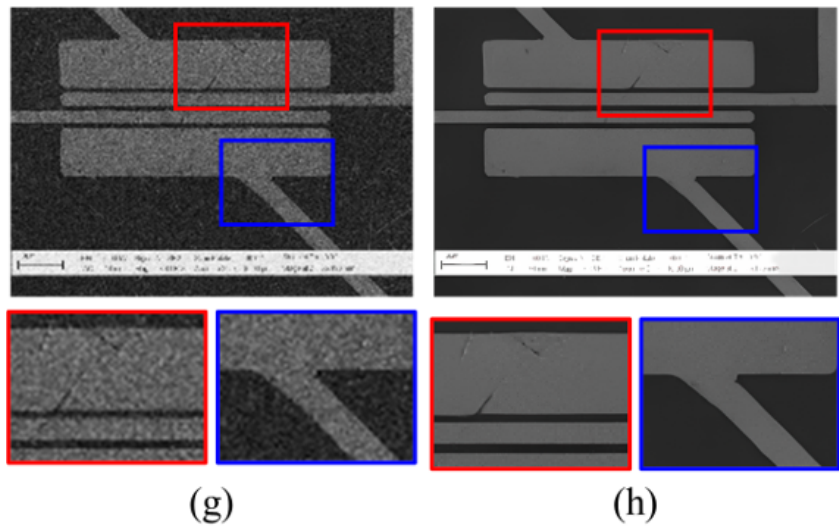
Figure 6. Qualitative comparison of the proposed scheme: ( a ) noisy LR image, ( b ) target HR image, ( c , e , g ) LR average 4 , LR average 8 , and LR average 16 input images, and ( d , f , h ) are SR results of ( c , e , g ) input LR average images, respectively. The baseline model SwinIR is used with a fixed noise level variance of 60 for fair comparison.